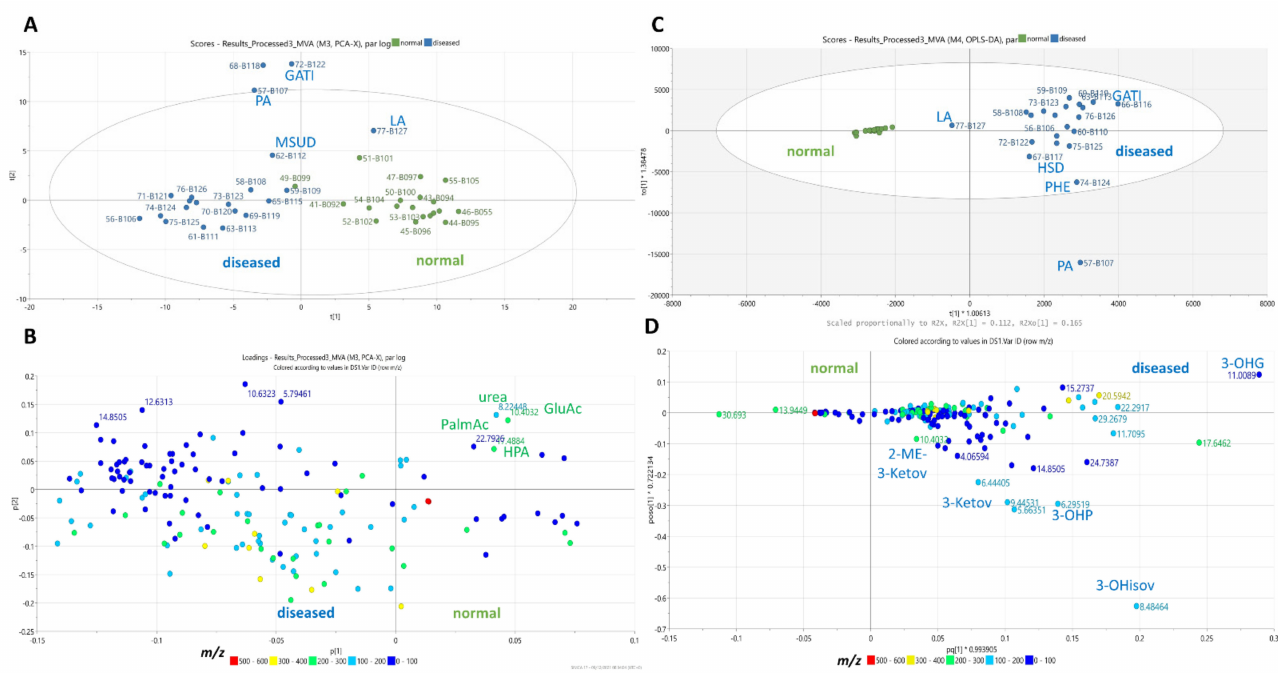
Figure 5. Multivariate analysis of GC–MS data of healthy samples vs. samples with diagnosed IEM disorders. ( A ) PCA scores plot, ( B ) PCA loadings plot, ( C ) OPLS-DA scores plot, and ( D ) OPLS-DA loadings plot. Legend: propionic acidemia (PA), holocarboxylase synthetase deficiency (HSD), glutaric acidemia type I (GAT1), lactic aciduria (LA), maple syrup urine disease (MSUD), and disorders of phenylalanine metabolism (PHE). Labelled features with their retention time correspond to identified metabolites from the in-house in line database such as urea, palmitic acid (PalmAc), glutaric acid (GluAc), hippuric acid (HPA), 3-hydroxy-propionic acid (3OHP), 3-ketovaleric acid (3-Ketov), 2-methyl-3- ketovaleric acid (2-ME-3-Ketov), 3-hydroxy-isovaleric acid (3-OHisov), and 3-hydroxy-glutaric acid